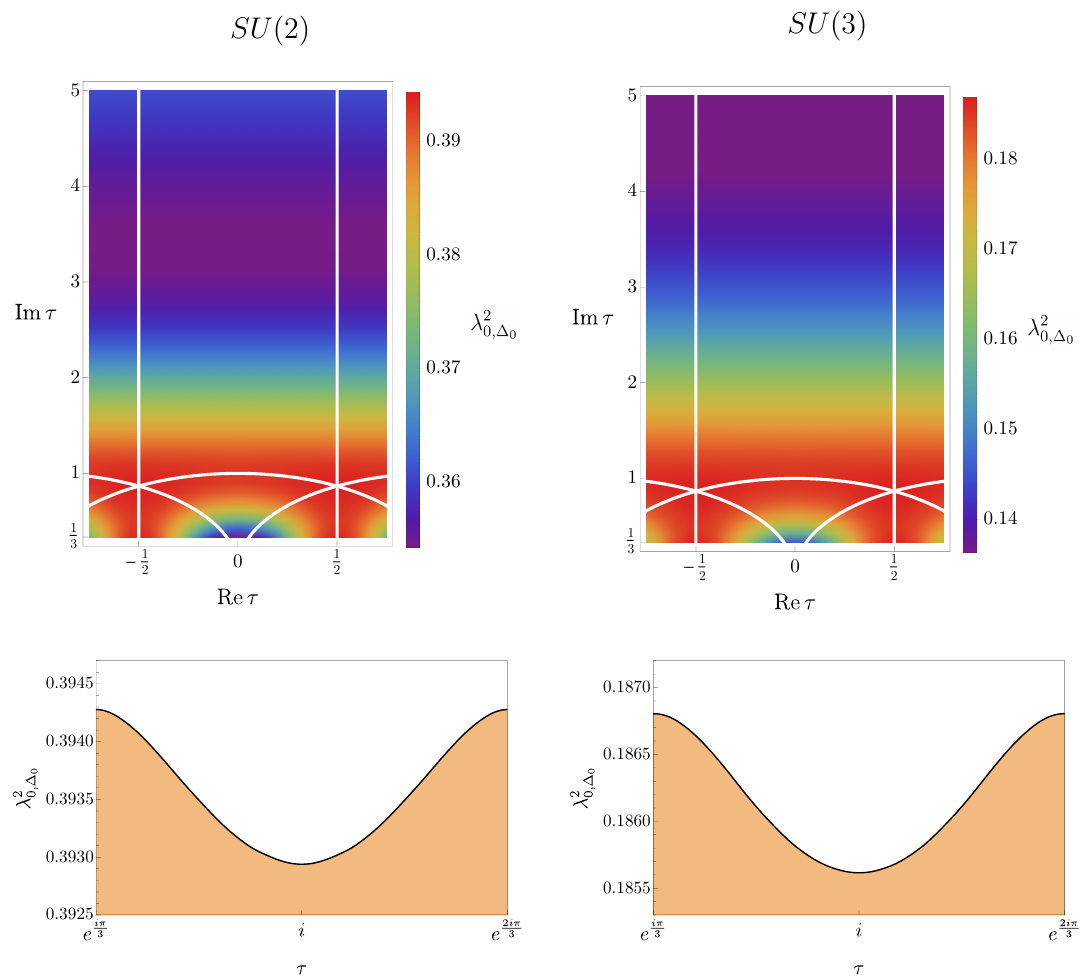
Figure 10 . The upper bounds on the OPE coefficient of the lowest scalar for SU (2) and SU (3) as a function of complex coupling τ , obtained with bootstrap resolution Λ = 39 . The bottom panels show how these bounds vary along the bottom boundary of the fundamental domain, the arc from e πi/ 3 to e 2 πi/ 3 . Note that, like the localization inputs, the slope of these upper bounds go to zero